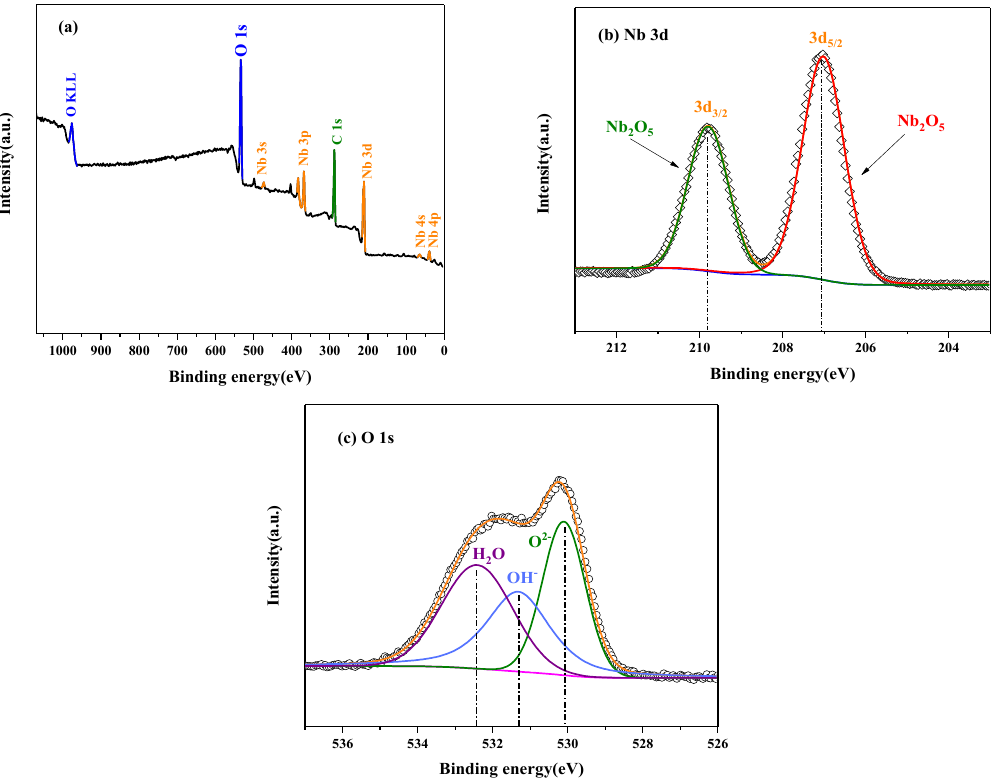
Figure 9. ( a ) Typical XPS spectrum and ( b , c ) high-resolution XPS spectra of Nb 3 d and O 1 s for the passive film developed on the niobium coating.